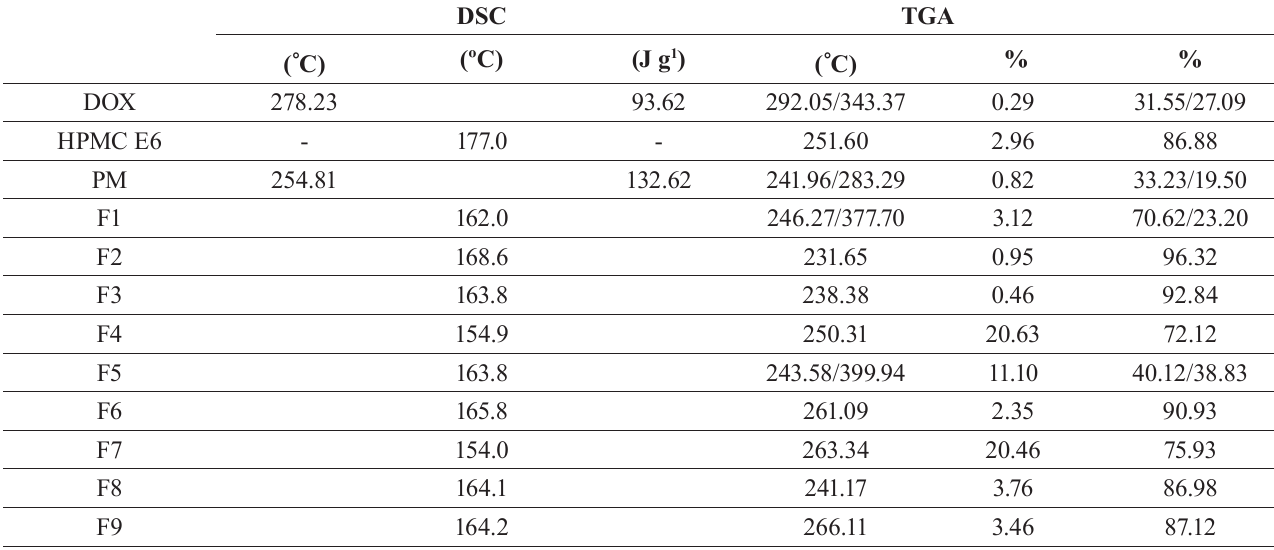
TABLE II - Data obtained for doxazosin mesylate (DOX), hydroxypropyl methylcellulose (HPMC) E6, physical-mixture 1:1 (w/w) (PM), and orodispersible films (F1-9) from (TGA) and differential scanning calorimetry (DSC)